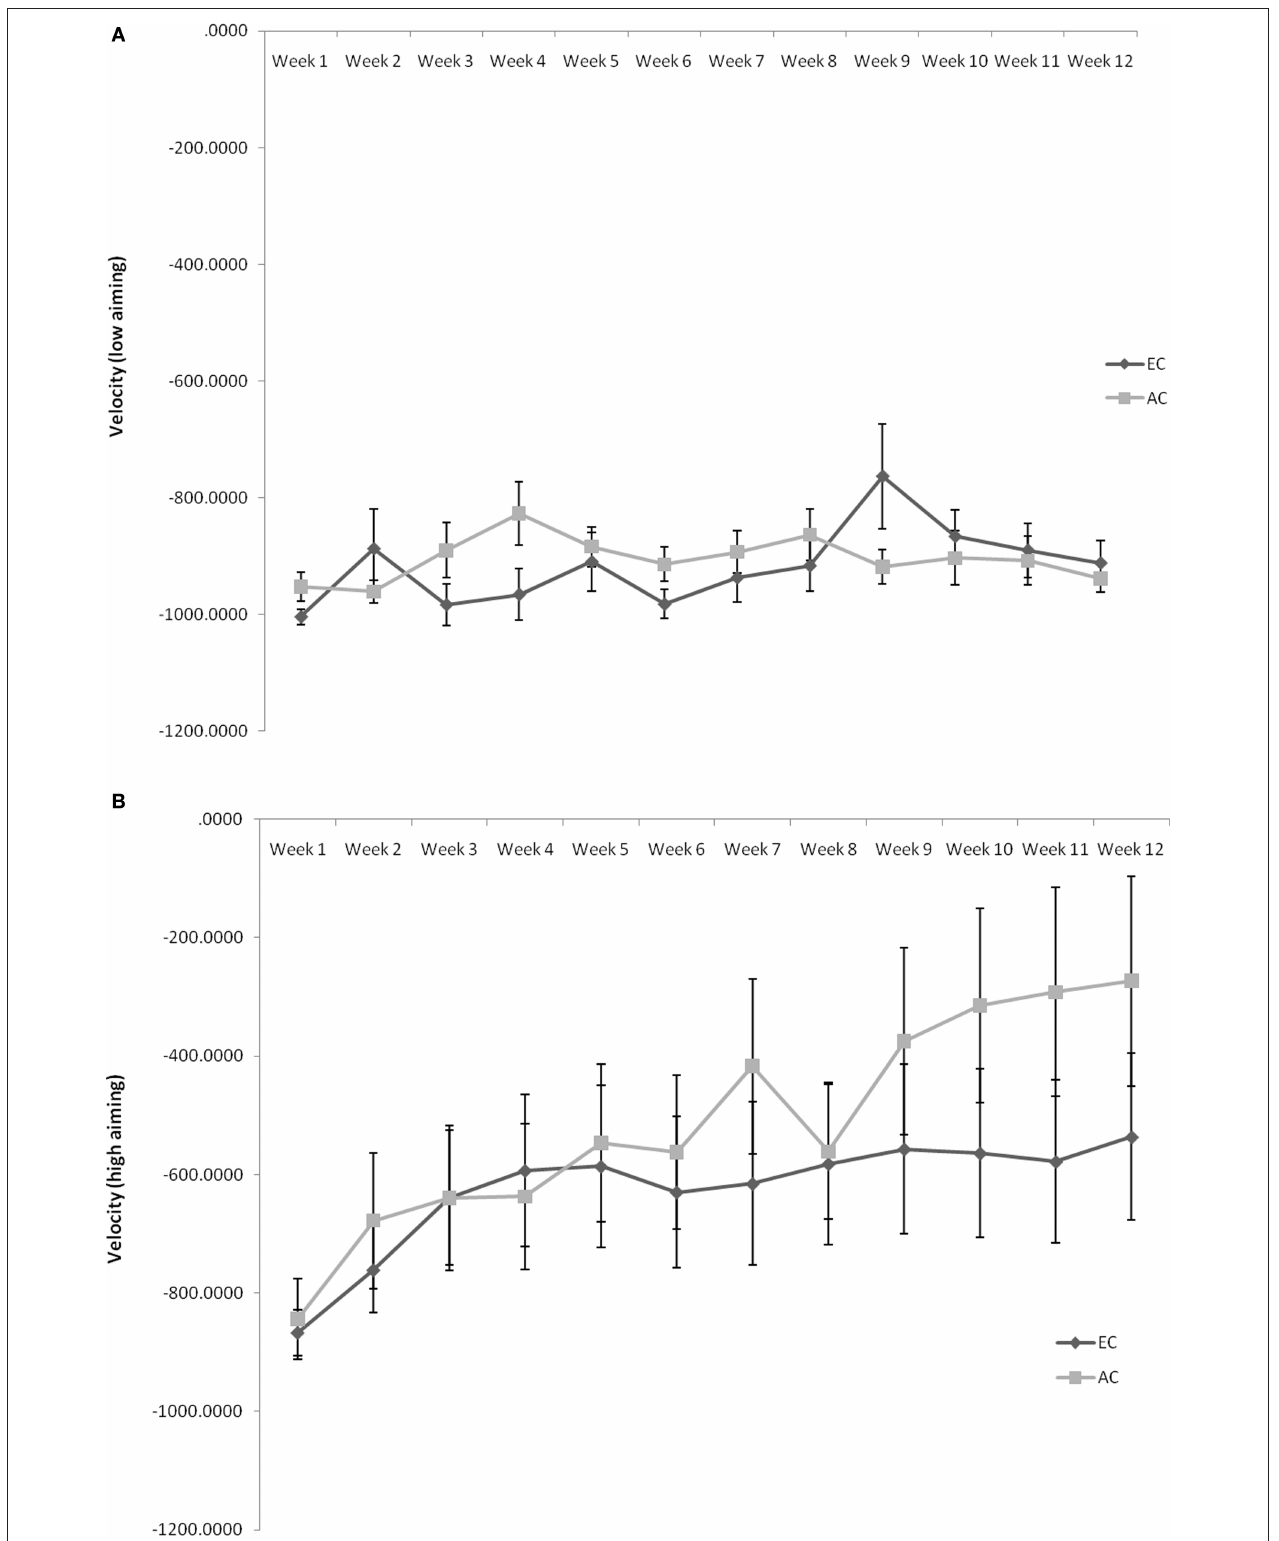
FiGurE 3 | (A) Velocity as a function of training instructions (EC vs. Standard) in participants with low ( < 450) subject-specific aiming scores. (b) Velocity as a function of training instructions (EC vs. Standard) in participants with high ( > 450) subject-specific aiming